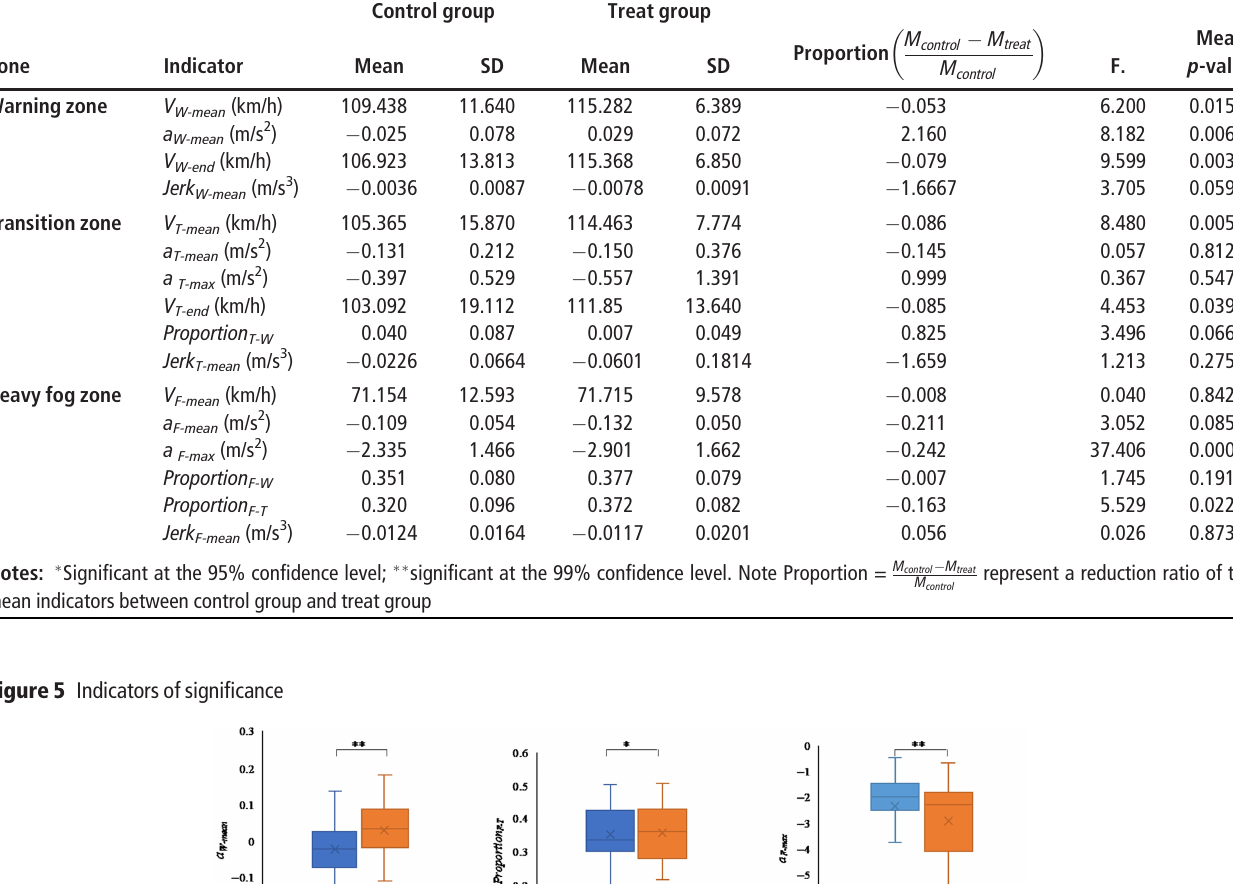
Figure 5 Indicators of signi fi